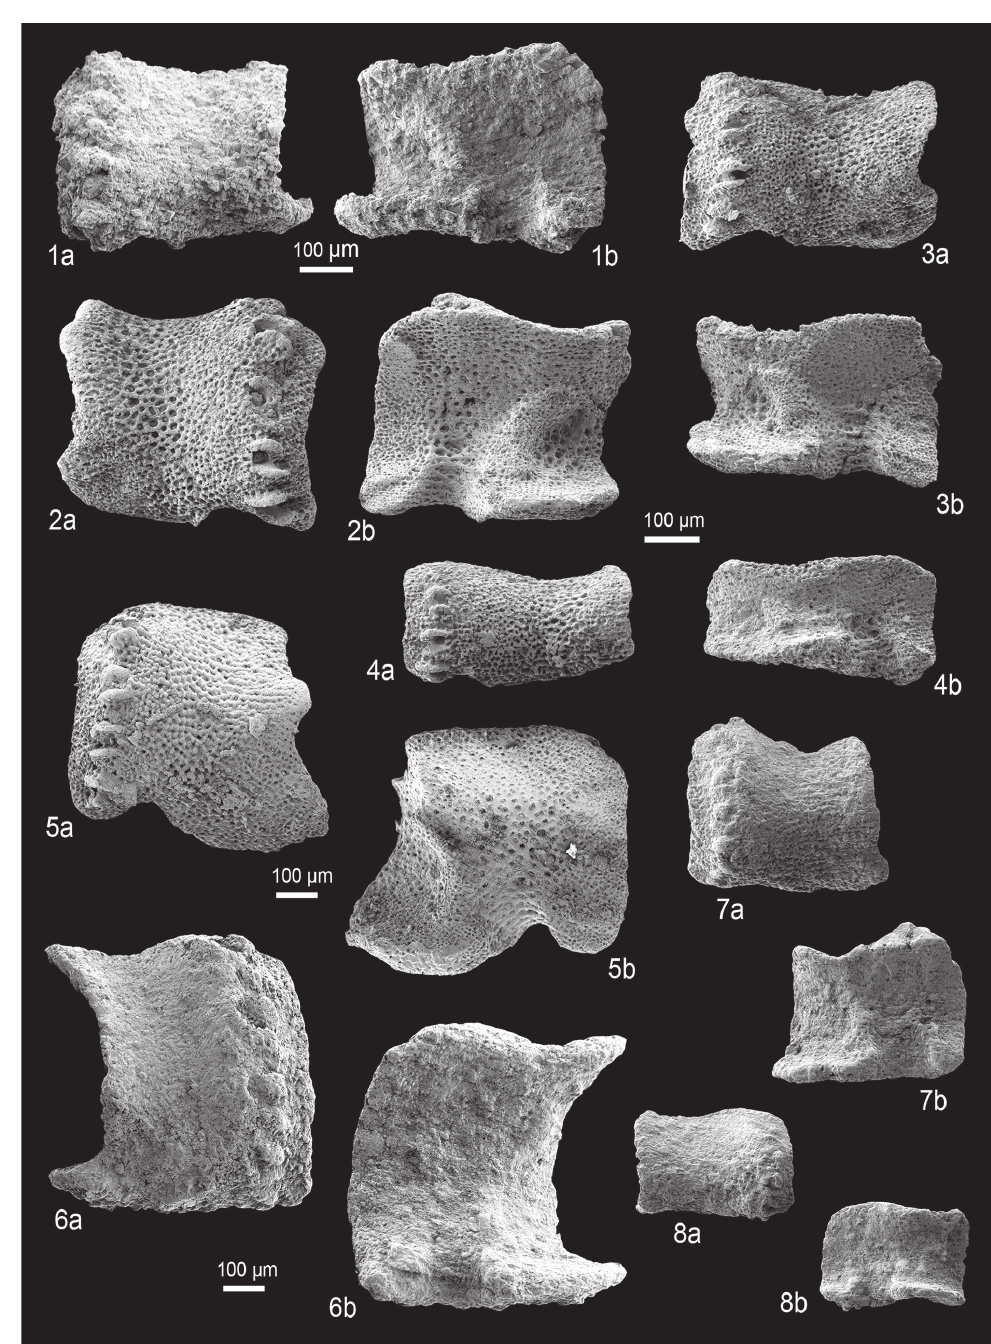
Fig. 6. Fossil lateral arm plates (LAPs) of ophiacanthid brittle stars in external (a) and internal (b) views. 1. Eolaxoporus sp. from the latest Anisian (Middle Triassic) of Oberscheffach, Germany, MHI 2083/1, median LAP. 2-4. Eolaxoporus hagdorni gen. et sp. nov. from the late Carnian (Late Triassic) of Jushui, China. 2. MHI 2084/1 (holotype), proximal LAP. 3. MHI 2085/1 (paratype), median LAP. 4. MHI 2086/1 (paratype), distal LAP. 5. Eolaxoporus sp. nov. innom. from the early Carnian (Late Triassic) of Milieres, Italy; GZG.INV.78500, proximal to median LAP. 6-8. Eolaxoporus imminens gen. et sp. nov. from the late Sinemurian to early Pliensbachian (Early Jurassic) of the Glasenbach Gorge, Austria. 6. NHMW 2012/0137/0001 (holotype), proximal LAP. 7. NHMW 2012/0137/0002 (paratype), median LAP. 8. NHMW 2012/0137/0003 (paratype), distal LAP. One common scale bar per species is